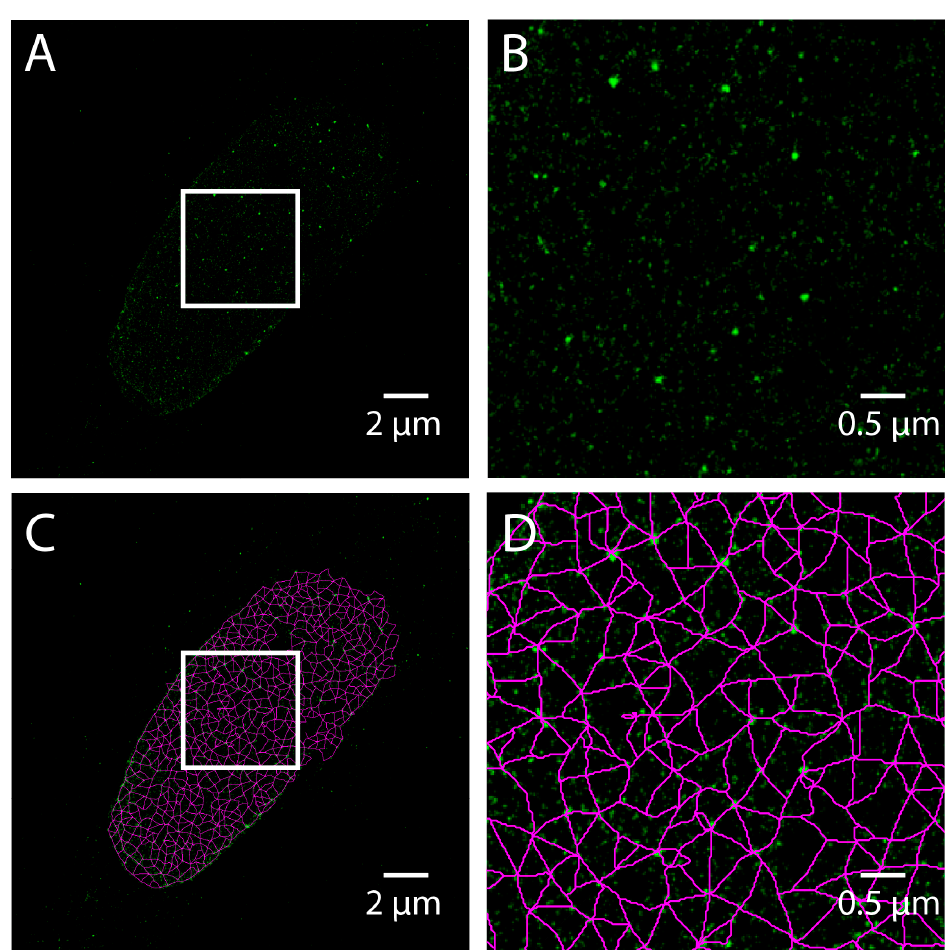
Figure 6. Steerable Filter Based Meshwork Analysis of a Total Internal Reflection Fluorescence – Stochastic Optical Reconstruction Microscopy (TIRF-STORM) Image of a normal Human Skin Fibroblast. TIRF-STORM image of Lamin A labeled human dermal fibroblast is rendered by binning fluorophore coordinates into a 20 nm pixel grid ( A ). The area in the white box (A) is magnified by four times ( B ). The steerable filter meshwork analysis as detailed for SIM applied ( C ) to the TIRF-STORM image (A). The area in the white box (C) is magnified by four times ( D ). The white scale bars are 2 micrometers (zoomed out) or 0.5 micrometers (zoomed